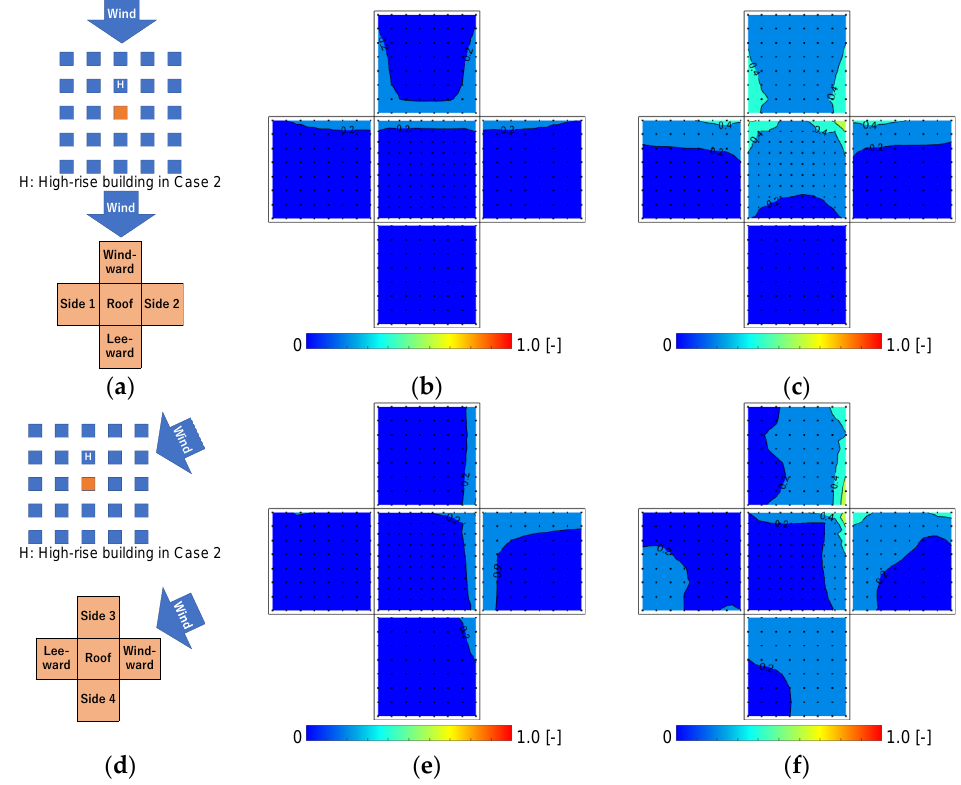
Figure 15. Fluctuating wind pressure coefficient 𝐶 𝑝′ ; ( a ) building model arrangement and prevailing wind direction for ( b , c ); ( b ) wind direction of 0 ◦ in Case 0 with no high-rise building; ( c ) wind direction of 0 ◦ in Case 2 with a high-rise building next to the pressure measurement model; ( d ) building model arrangement and prevailing wind direction for ( e , f ); ( e ) wind direction of 65 ◦ in Case 0; ( f ) wind direction of 65 ◦ in Case